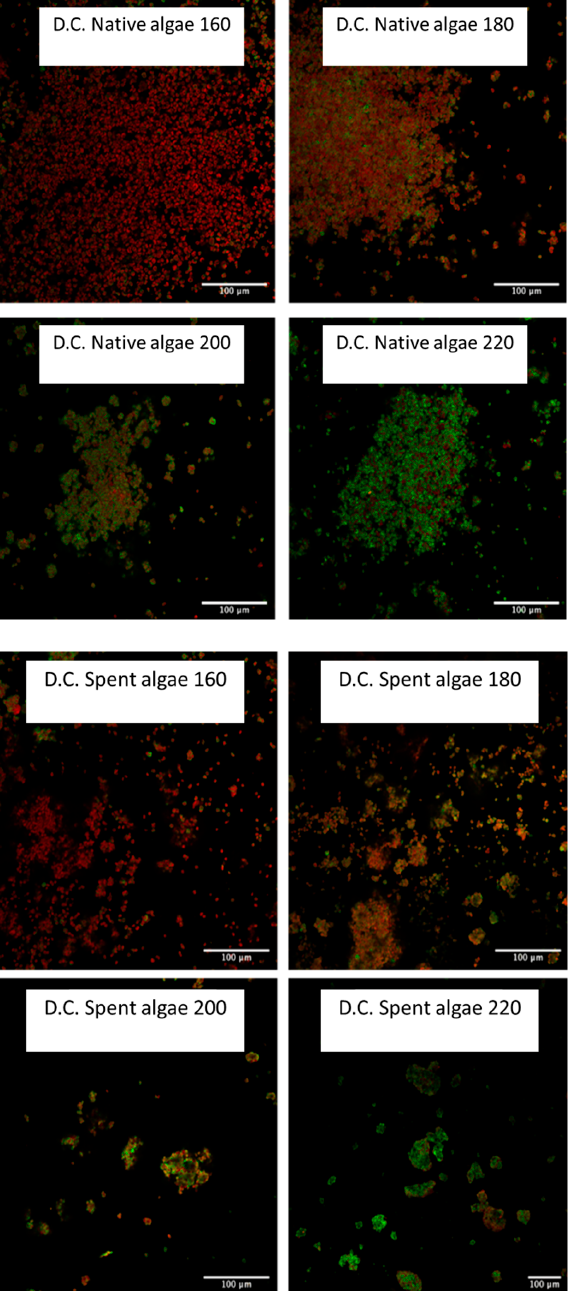
Figure 7. Laser Confocal Microscopy Images of all native algal derived and spent derived defibrillated celluloses.